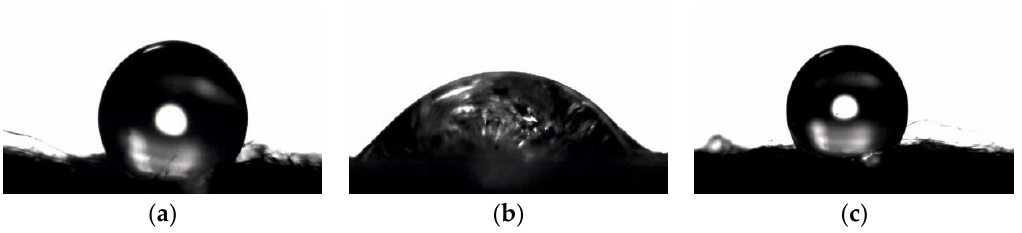
Figure 10. Contact angle images for: ( a ) — PLA, ( b ) — PLA-ALG-Na (+) , ( c ) — PLA-ALG-Zn (2+) . As shown in Figures 10 and 11, modification of PLA nonwoven fabric with sodium